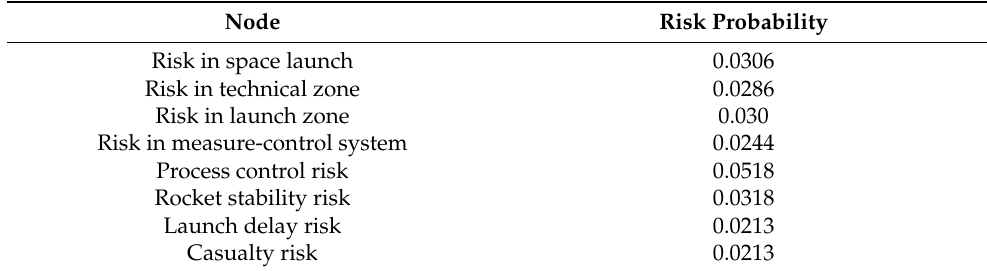
Table 8. Risk probability of the nodes in the